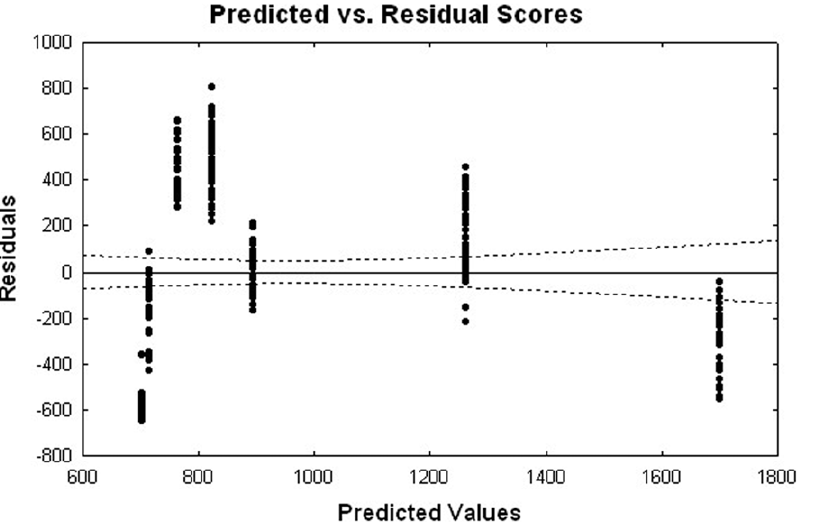
Figure 2. A residual plot for the GnRHR pharmacoperone assay. To assess the validity of the model assumptions, the plot of the Studentized residuals versus the predicted values, along with 95% confidence interval, is displayed.